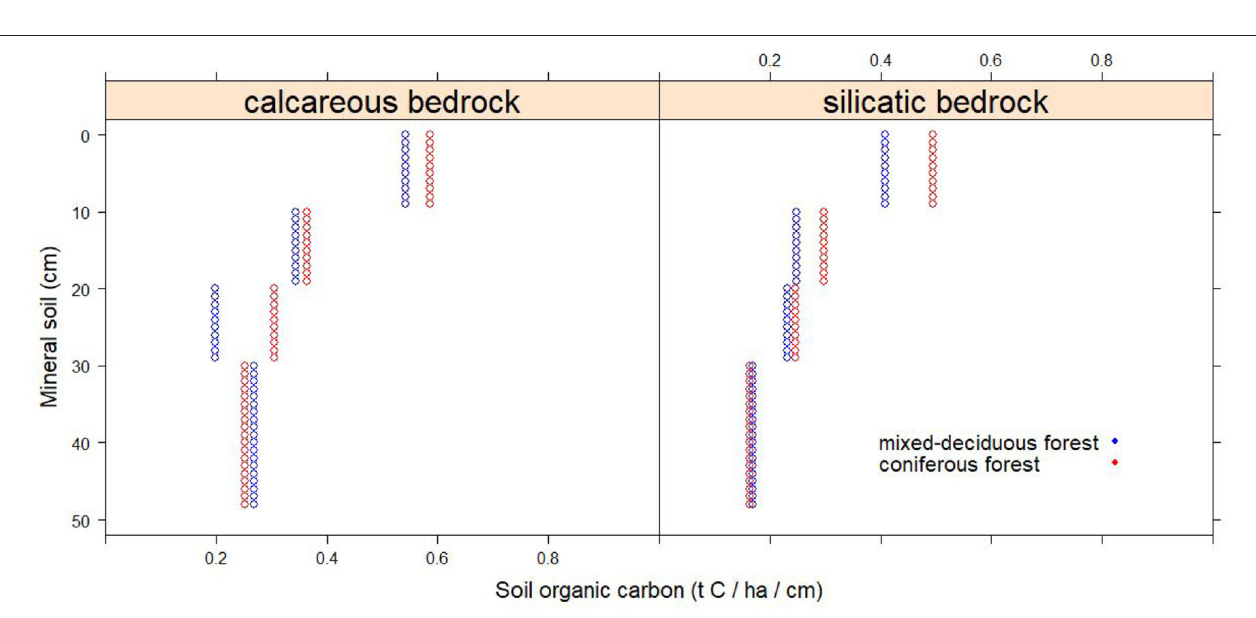
FIGURE 5 | Depth gradients of soil organic carbon in the mineral soil of coniferous and mixed-deciduous forest stands differentiated between sites on calcareous vs. silicatic bedrock.